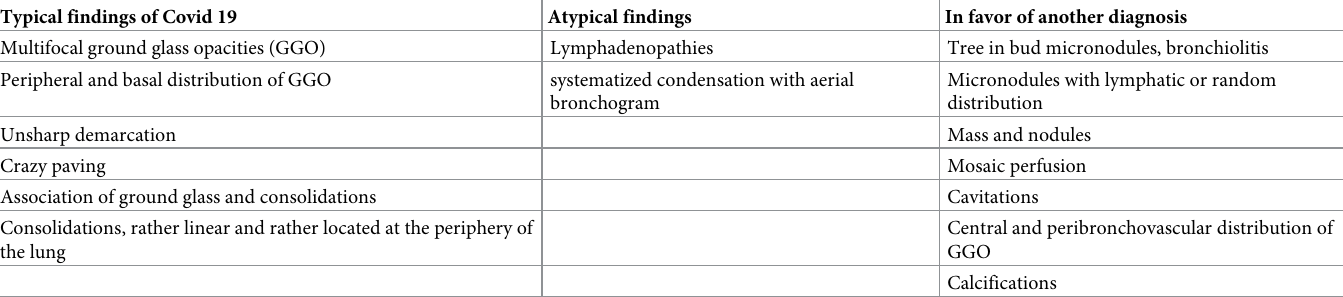
Table 1. Imaging findings used in the standardized